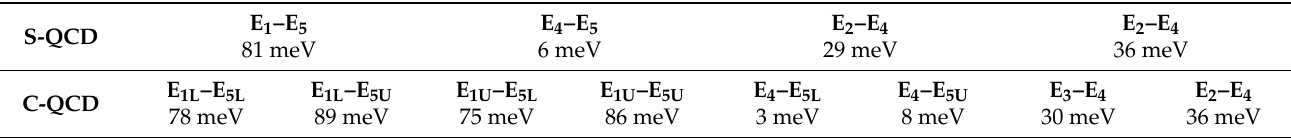
Figure 4. Band structures and schematic diagram of the QCD. Conduction band structures and wave functions of samples ( a ) S-QCD and ( b ) C-QCD. The colored background represents the active region (blue) and transport region (green). ( c ) Schematic diagram and migration of electrons in the cascade structure. Table 1. Energy separations in the two QCD